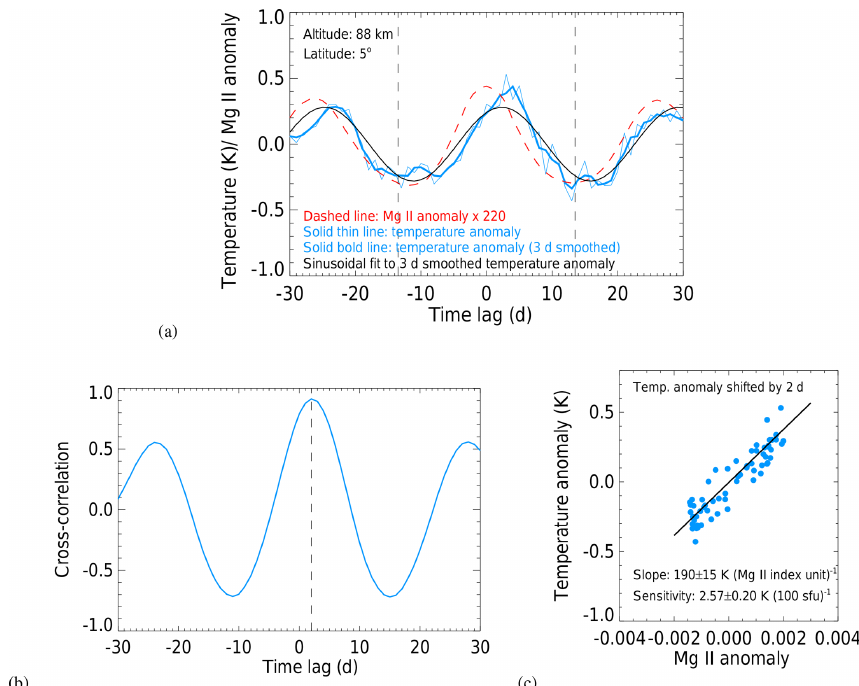
Figure 7. (a) Epoch-averaged Mg II index and temperature anomalies for a total of 173 epochs. The dashed red line is the epoch-averaged Mg II index anomaly multiplied by a factor of 220. The solid thin blue line corresponds to the epoch-averaged temperature anomaly. The solid bold blue line represents the temperature anomaly smoothed with a 3d running mean. The black line is a sinusoidal fit to the 3d smoothed epoch-averaged temperature anomaly, with an amplitude of 0.28K. (b) Cross correlation between the 61d epoch-averaged temperature and Mg II index anomaly time series (the results correspond to the 35d running mean) for the time lag between − 30 and + 30d. (c) Scatter plot of the 2d lagged temperature and Mg II index anomalies based on the epoch averages displayed in (a) . The black line represents the fitted linear regression line.